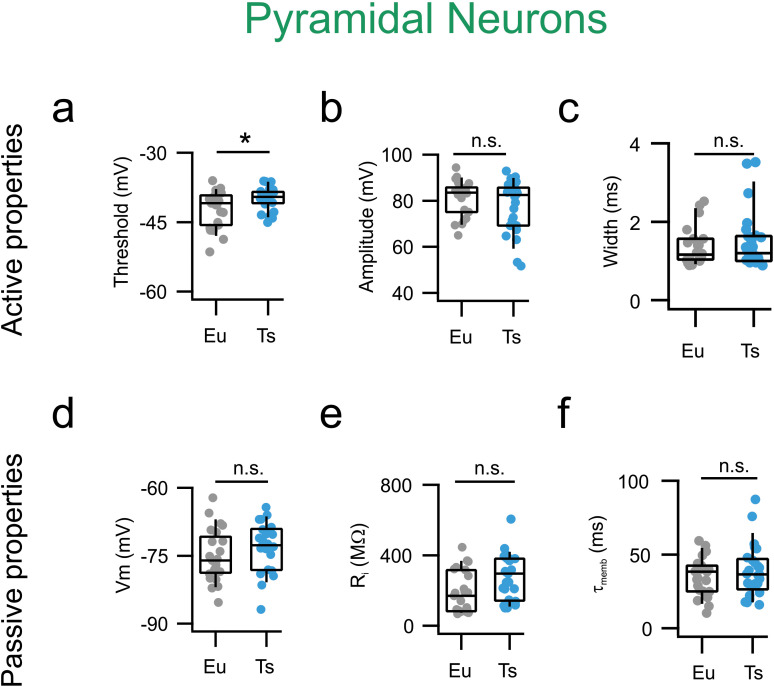
Single action potential and passive properties are normal Ts mPFC PNs.(a) AP thresholds estimated as the voltage at which the derivative of Vm as function of time (dV/dt) reaches the limit of 10 mV/ms. Eu: −41 mV, −45–39 mV (n = 23 cells) and Ts: −40, −41–39 mV mV (n = 25 cells; Mann-Whitney U-test, p=0.0453). (b) AP amplitude measured as the difference between Vm at threshold and Vm at peak Eu: 84, 75–86 mV (n = 23 cells) and Ts: 82, 69–85 mV (n = 25 cells; Mann-Whitney U-test, p=0.37486). (c) AP width. Eu: 1.2, 1–1.6 ms (n = 23 cells) and Ts: 1.2, 1–1.6 ms (n = 25 cells; p=0.74125, Mann-Whitney U-test). (d) Resting membrane potential was also not significantly different between genotypes. Eu: −76, −79–72 mV (n = 23 cells) and Ts: −73, −78–69 mV (n = 25 cells; p=0.74125, Mann-Whitney U-test). (e) Input resistance, Eu: 255, 139–378 MΩ (n = 23 cells), Ts: 178, 86–316 MΩ (n = 25 cells, p=0.05918, Mann-Whitney U-test). (f) Decay tau of the membrane Eu: 37, 28–48 (n = 23 cells), Ts: 40, 27–47 (n = 25 cells, p=0.90665, Mann-Whitney U-test). Boxplots: represent median, percentiles 25 and 75 and whiskers are percentiles 5 and 95. Individual points represent average values from individual cells.Figure 2—figure supplement 1—source data 1.Singleaction potentialand passive properties of mPFC PNs.